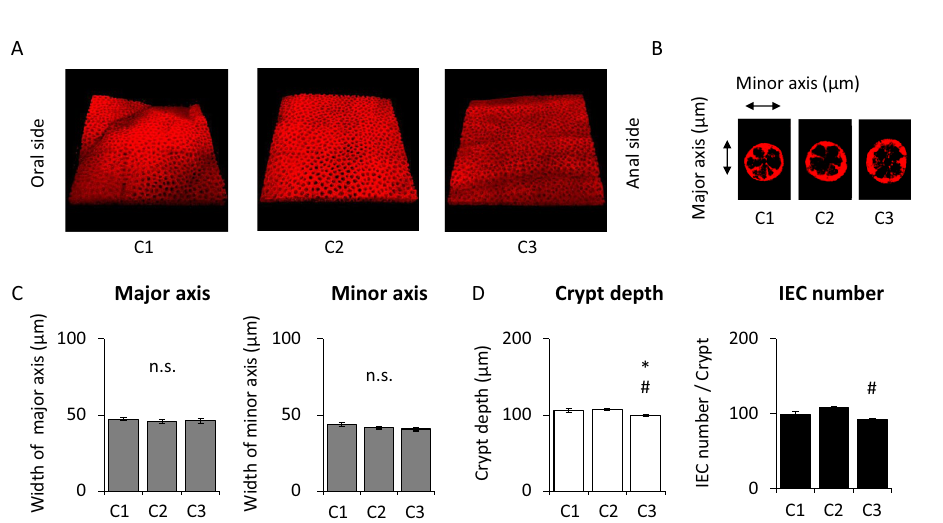
Figure 3. Morphology and analysis of the colon in Villin1-Tomato mice. ( A ) The whole images of colon and ( B ) the cross section of crypts. ( C ) Width of crypt major axis and minor axis, ( D ) crypt depth, and intestinal epithelial cell (IEC) number per crypt of each section in colon (n = 50 crypts in 5 mice). *P < 0.05 vs. C1, # P < 0.05 vs. C2. n.s. not